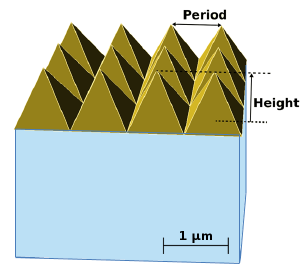
Figure 23. Schematic configuration of a square-placed pyramid pattern. These pyramids are touching each other at the base and are defined by the height h and the Period P. The diameter is fixed to the value P/2 [61].